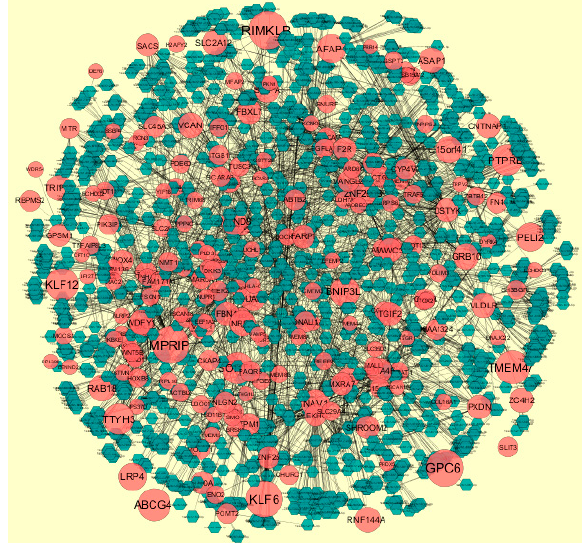
Figure 13. The network of down-regulated DEGs and their related miRNAs. The red circle nodes are the down-regulated DEGs, and green diamond nodes are miRNAs. Black lines means interaction with adjutant genes or miRNAs.